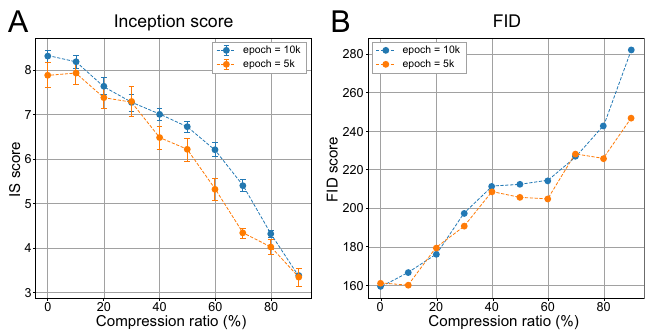
Figure 7. Performance of cross-modal GAN in terms of the ( A ) inception score (IS) and ( B ) Fréchet inception distance (FID) over the change of the compression ratio. The compression ratio for the experiment increased linearly from 10% to